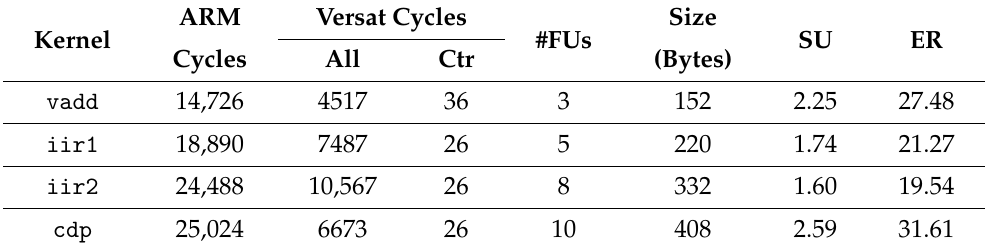
Table 6. Simple kernel